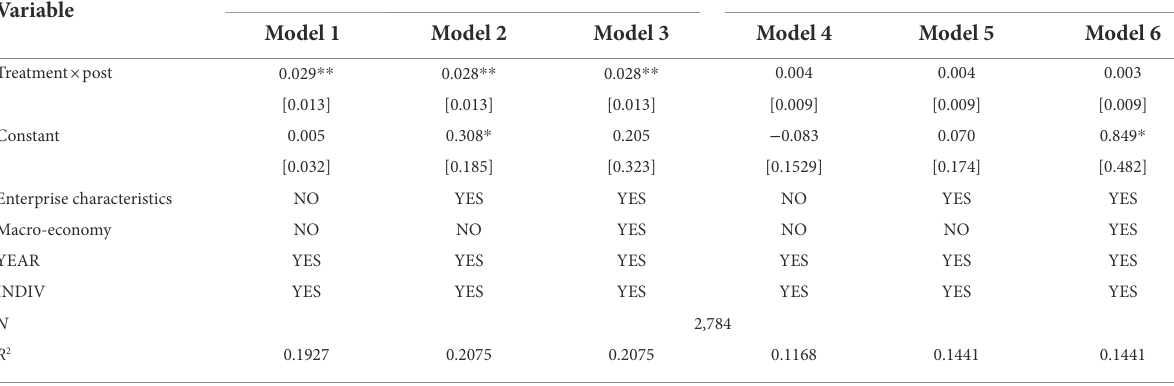
TABLE 4 Results of multiple difference in difference